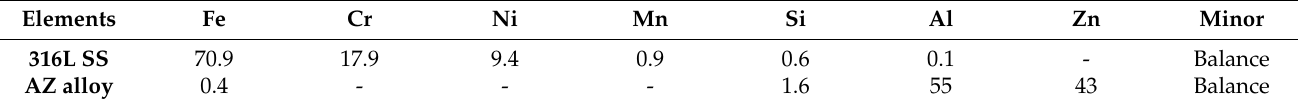
Table 1. Chemical compositions of the 316L SS and Al-Zn-Si coating